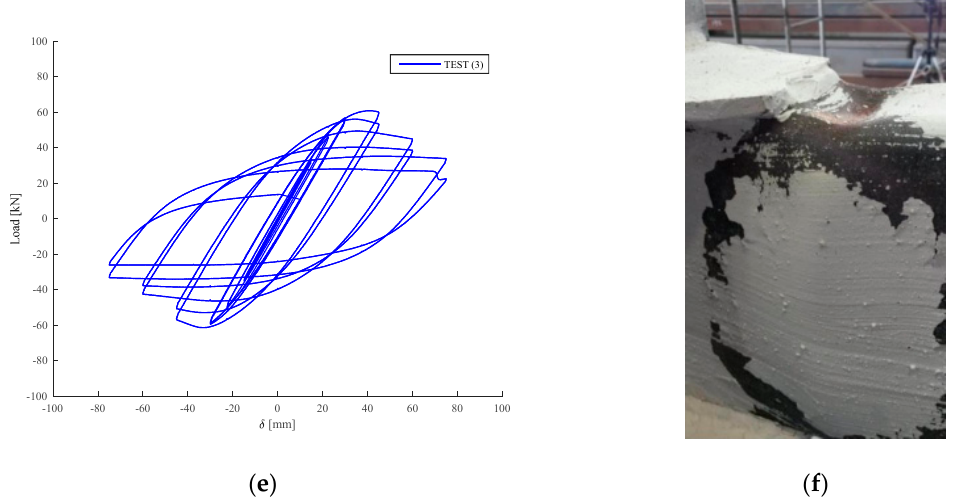
Figure 5. ( a ) Load vs. displacement hysteresis curve of test 1, ( b ) view of damage in test 1, ( c ) load vs. displacement hysteresis curve of test 2, ( d ) view of damage in test 2, ( e ) load vs. displacement hysteresis curve of test 3, ( f ) view of damage in test 3.